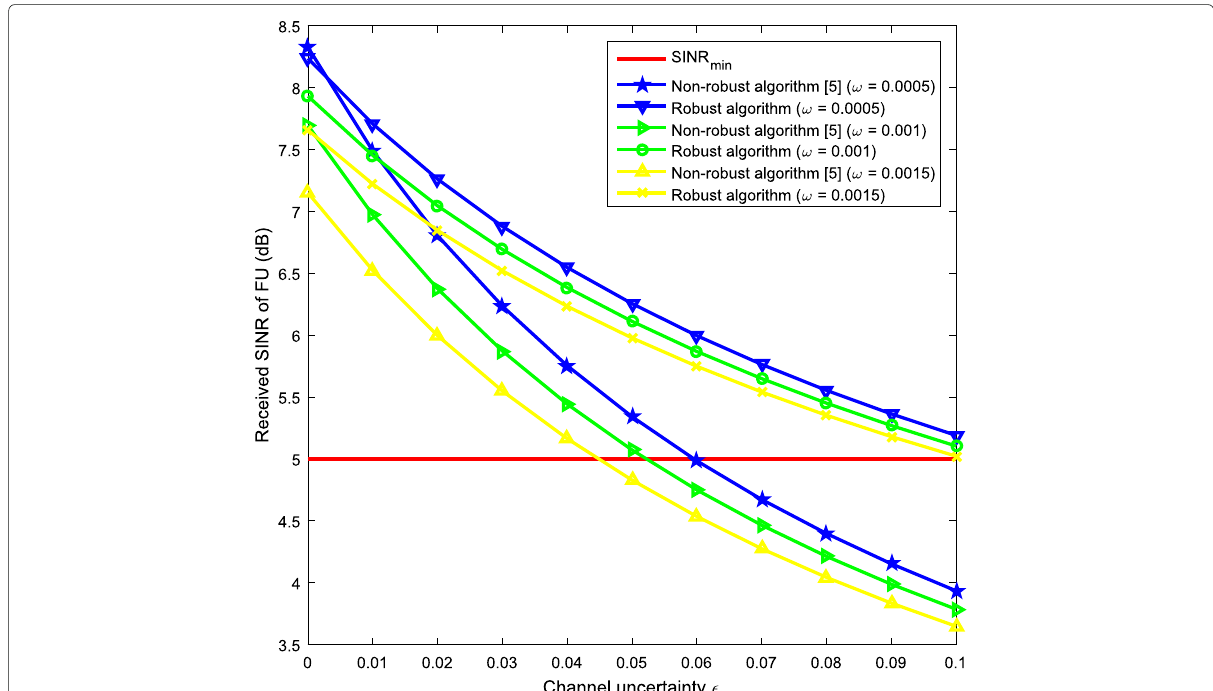
Fig. 7 Comparison of SINR between robust and non-robust algorithm under different channel perturbation (cid:16) and ω